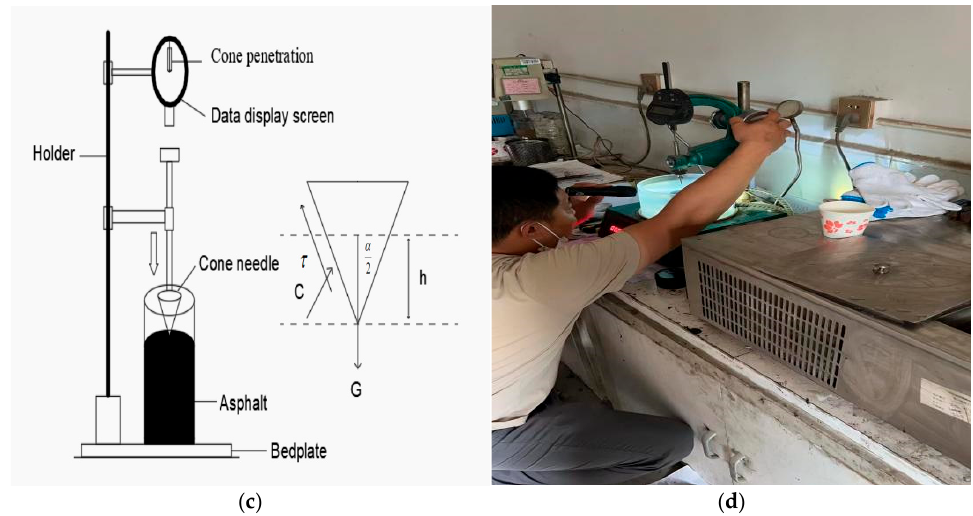
Figure 3. Cone penetration instrument: ( a ) Cone needle and weights; ( b ) Photo of the instrument; ( c ) Chart of cone penetration instrument; ( d ) Operating the instruments.